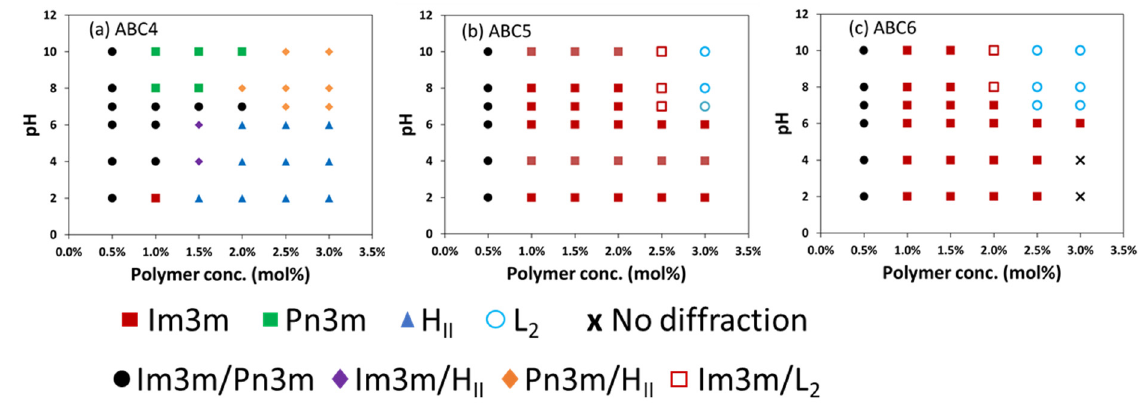
Figure 5. Mesophases of MO nanoparticles stabilized by PDMAEMA-containing polymers, viz. ABC4 ( a ), ABC5 ( b ) and ABC6 ( c ) at various concentrations in pH 2 to 10. All measurements were performed at 25 ° C.